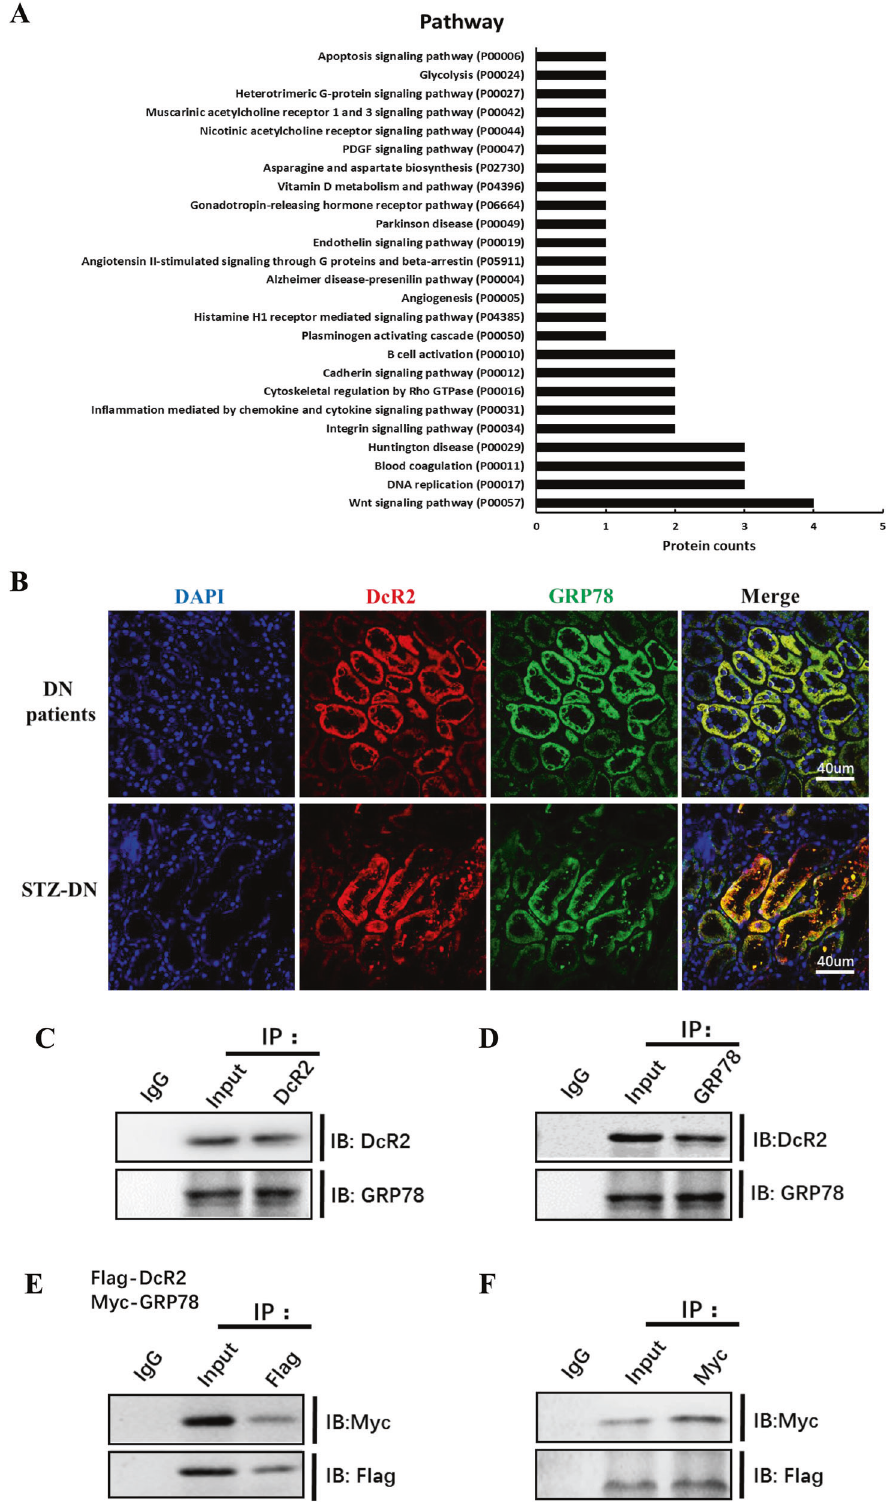
Fig. 5 Proteomic identi fi cation, functional analysis, and validation of DcR2-interacting proteins. A Pathway analysis for differentially expressed proteins in patients with DN versus controls. B Representative immuno fl uorescence staining for DcR2 (red) and GRP78 (green) in renal tissues from patients with DN and STZ-induced DN models ( n = 6 for each group). Scale bar, 40 μ m. C , D Reciprocal co- immunoprecipitation showing the interaction of DcR2 and GRP78 in STZ-DN ( n = 6). E , F Immunoprecipitation assays of RETCs co-transfected with Flag-DcR2 or Myc-GRP78, followed by immunoblotting with anti-Myc or anti-Flag, respectively ( n = 3).